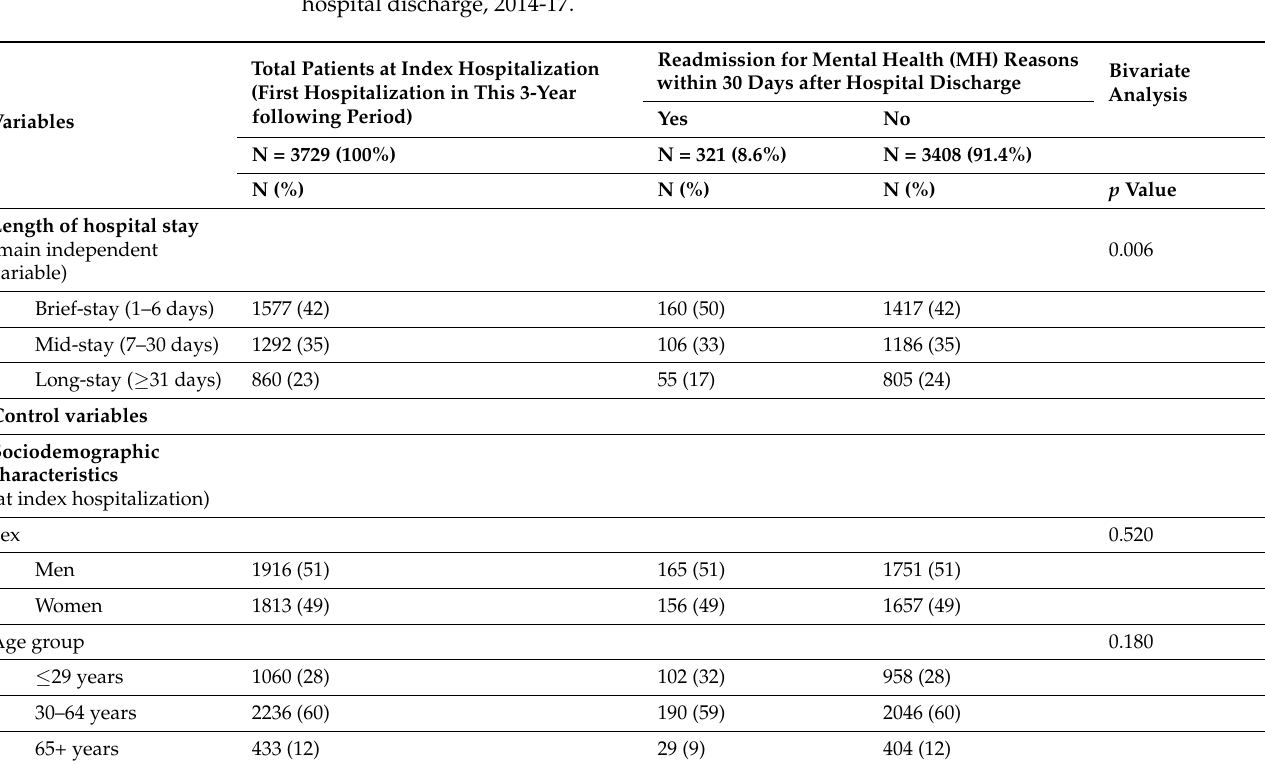
Table 2. Characteristics of patients readmitted or not for mental health reasons within 30 days after hospital discharge,